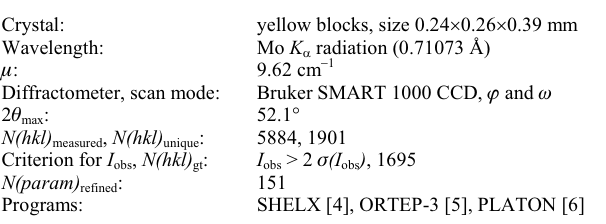
Table 1. Data collection and handling.